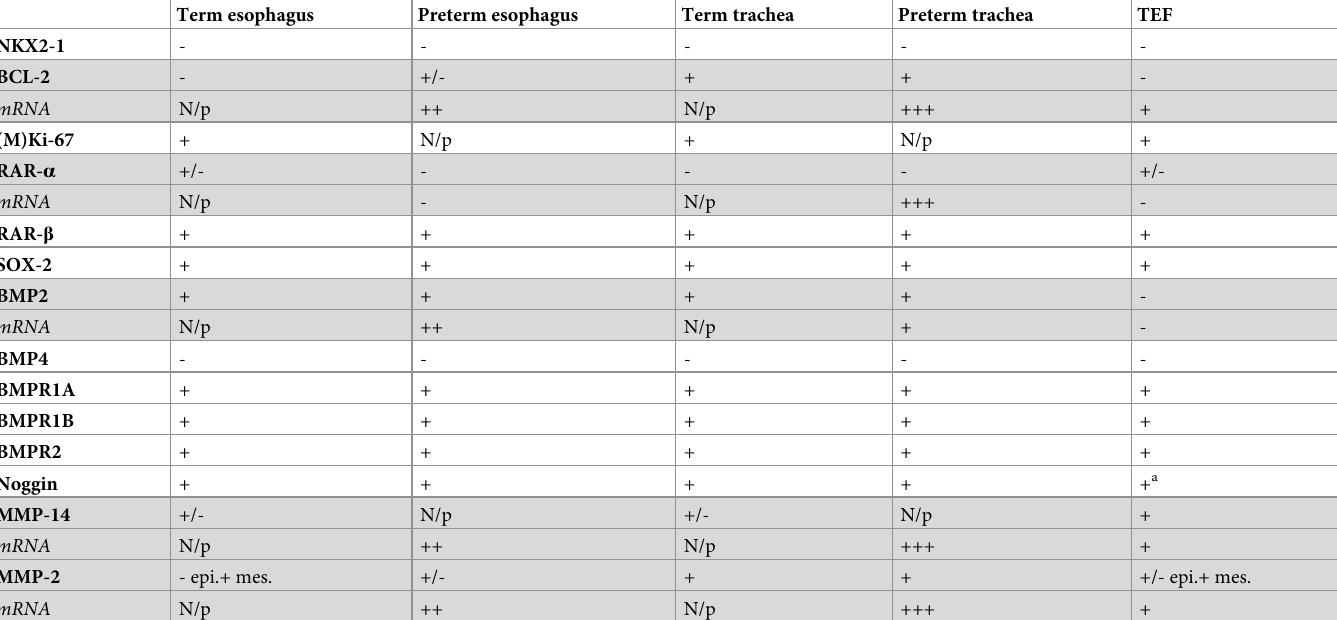
Table 5. Overview of the results of the immunohistochemical staining and differential expression analysis. Term esophagus